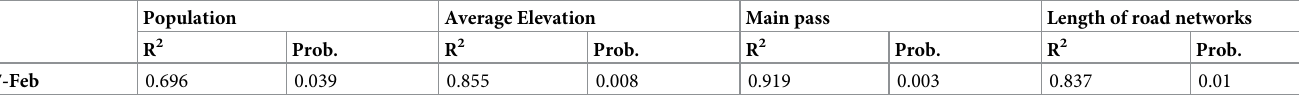
Table 6. The regression analysis between the factors and the NCCC in the second week. Population Average Elevation Main pass Length of road networks R 2 Prob. R 2 Prob. R 2 Prob. R 2 Prob.